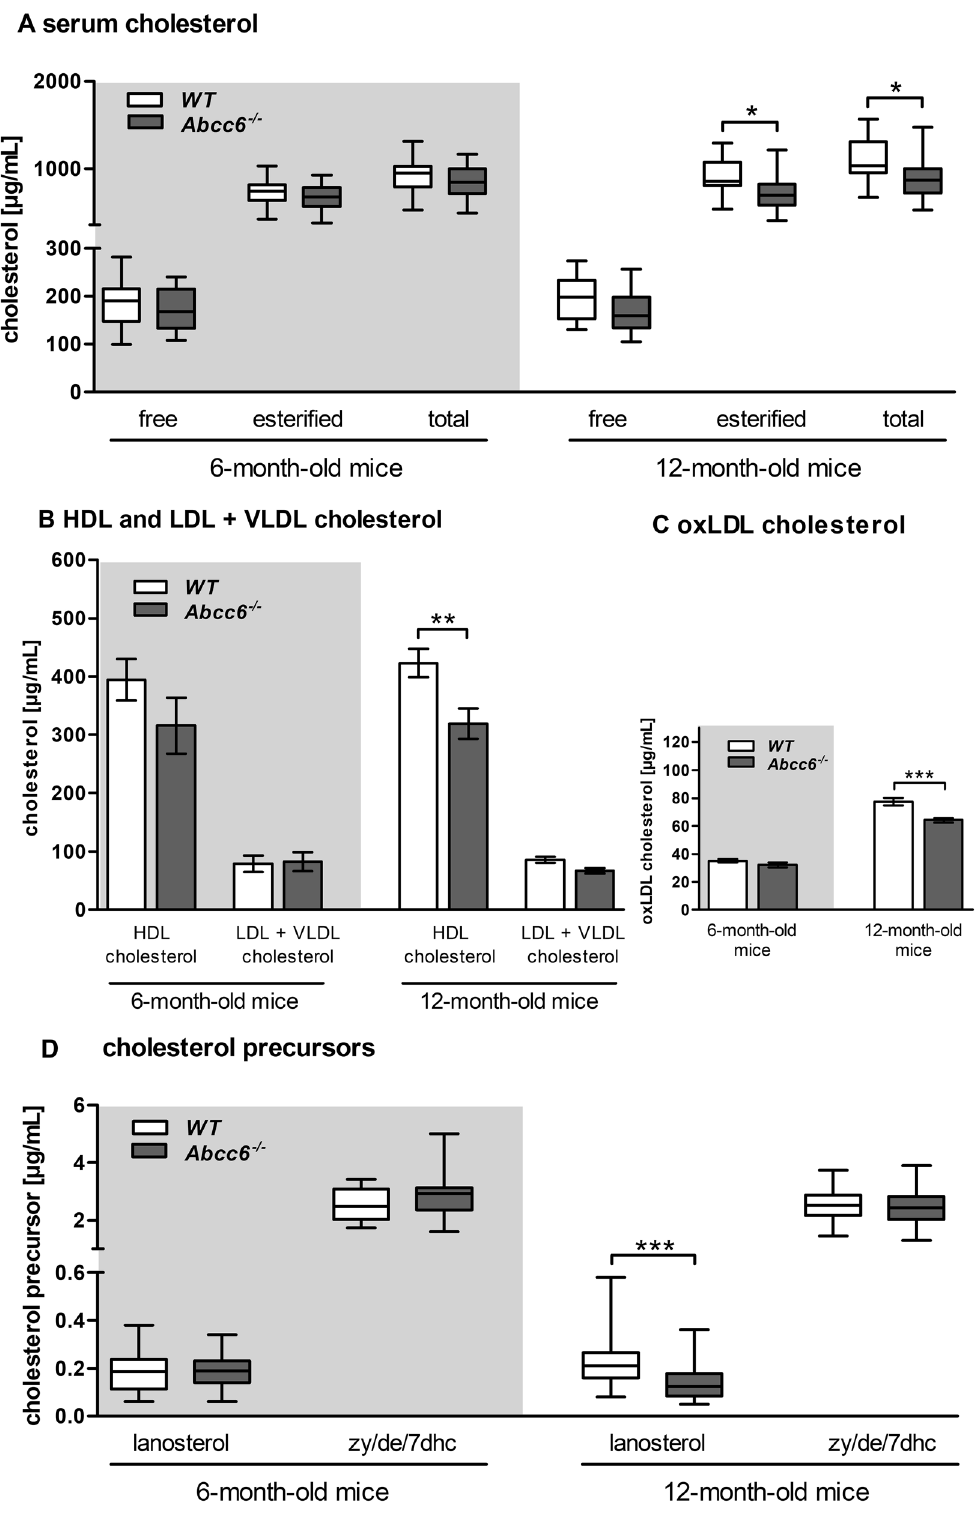
Figure 1. Reduced serum lipids in Abcc6 knockout mice. ( A ) Serum levels of free, esterified and total cholesterol of WT and Abcc6 −/− mice (6-month-old: WT n = 28, Abcc6 −/− n = 19; 12-month-old: WT n = 41, Abcc6 −/− n = 40). ( B ) Serum levels of HDL and LDL + VLDL cholesterol of WT and Abcc6 −/− mice (6-month-old: WT n = 8, Abcc6 −/− n = 4; 12-month-old: WT n = 18, Abcc6 −/− n = 17). ( C ) Quantification of oxLDL cholesterol serum levels of WT and Abcc6 −/− mice (6-month-old: